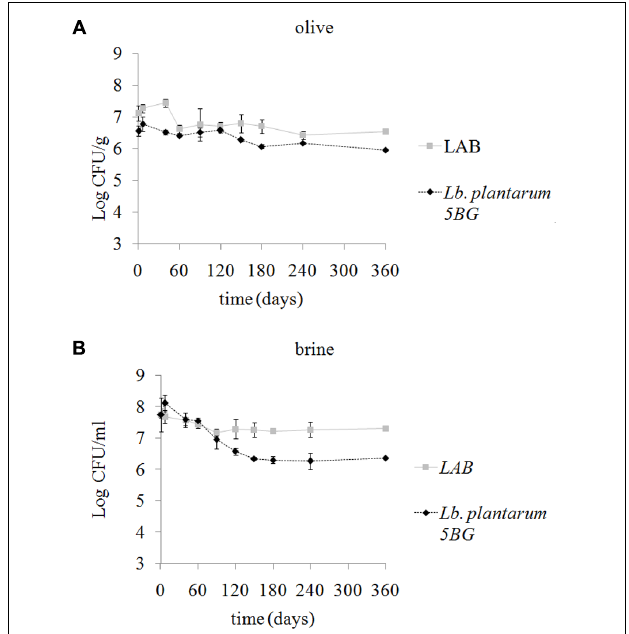
FIGURE 4 | Changes of the LAB population and survival of the bio-preserving strain Lb. plantarum 5BG on olives (A) and in cover brines (B) of SET1 Bella di Cerignola Spanish-style olives packaged in PTE bags (olive/brine ratio, 8/1) and stored at 4 ◦ C for 1 year. Means and standard deviations were obtained from measurements made in duplicate packages from two different experiments ( n = 4).